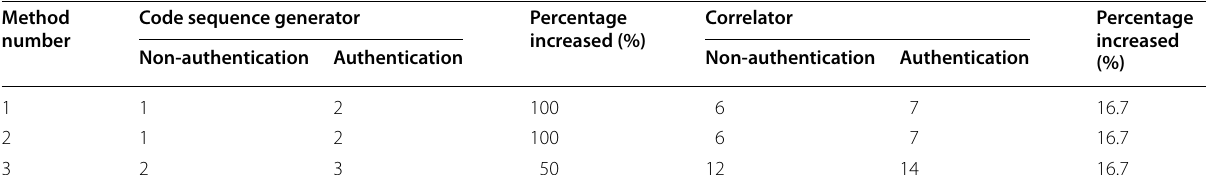
Table 1 Implementation complexity